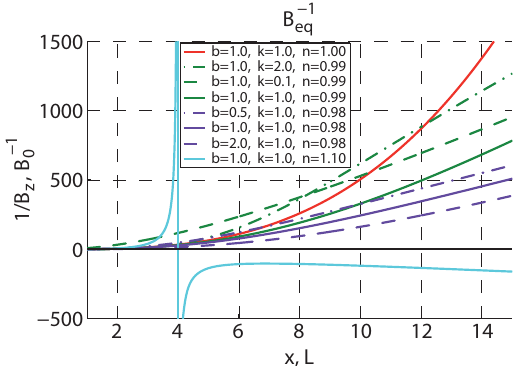
Figure 7. Profiles 1 /B z (x, 0 ) for symmetric Kan-like CS, calcu- lated from an analytical model (Eqs. 11–16). Parameters { a 1 = 0 , a 2 = 0 , ϕ = 0 , f = 0} are the same. Other parameters are { b 0 = 1 , k = 1 , n = 1 } (red), { b 0 = 1 , k = 2 , n = 0 . 99 } (dark-green dash- dotted), { b 0 = 1 , k = 0 . 1 , n = 0 . 99 } (dark-green dashed), { b 0 = 1 , k = 1 , n = 0 . 99 } (dark-green solid), { b 0 = 0 . 5 , k = 1 , n = 0 . 98 } (violet dash-dotted), { b 0 = 1 , k = 1 , n = 0 . 98 } (violet solid), { b 0 = 2 , k = 1 , n = 0 . 98 } (violet dashed), and { b 0 = 1 , k = 1 , n = 1 . 1 } (cyan). Red curve shows the original Kan solution. Units are nor- . malized for CS typical width L and for B − 1 0